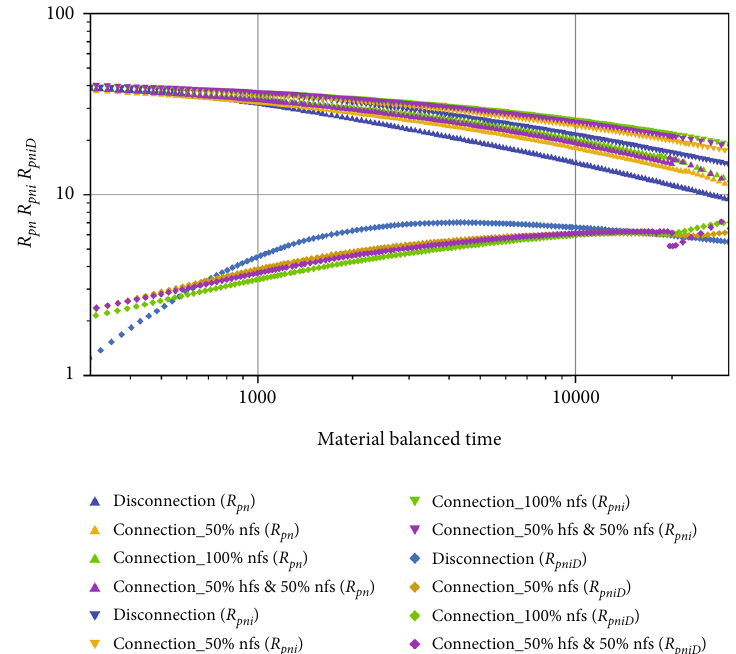
Figure 10: Blasingame type curves of di ff erent well connection conditions considering both hydraulic fractures and natural